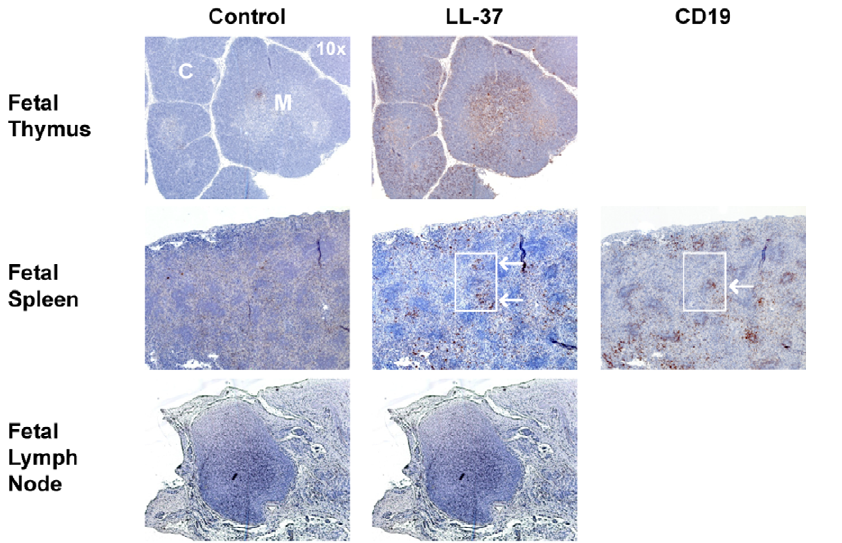
Figure 5. LL-37 is located in the cortex and medulla of the thymus and in non-B cell zones of the fetal spleen. Fetal thymus, spleen, and lymph nodes were formalin fixed and paraffin embedded. 4 um sections were mounted on slides and stained with a monoclonal antibody to LL-37 or CD19 followed by biotinylated rabbit anti-mouse antibody and streptavidin-biotin-peroxidase complex. IgG2a was used as control antibody. (C) cortex; (M) medulla. The fetal tissues were obtained from the same donor.